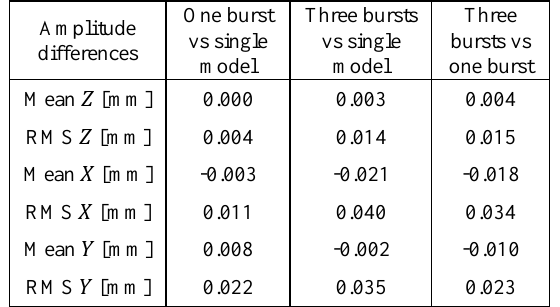
Table 8. Bias and RMSE of the estimated amplitude values between the different adjustments (3 Hz)